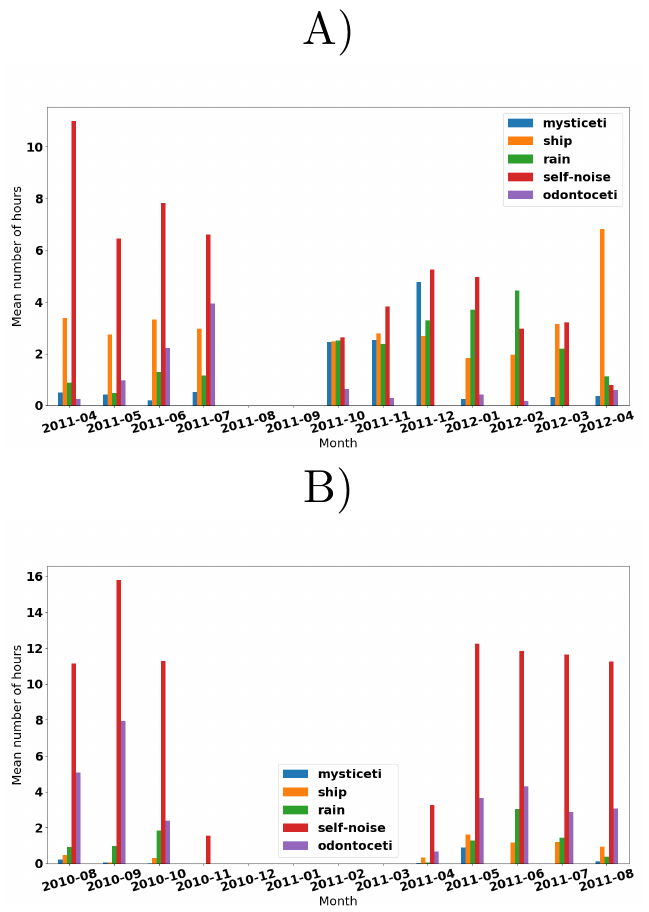
Figure 2. Mean number of hours per day by month for site ( A ) ( upper ) and site ( B ) ( lower ) campaigns for mysticetes, odontocetes, rain, ships, and the self-generated noise. Blank periods indicate that no data were available for that